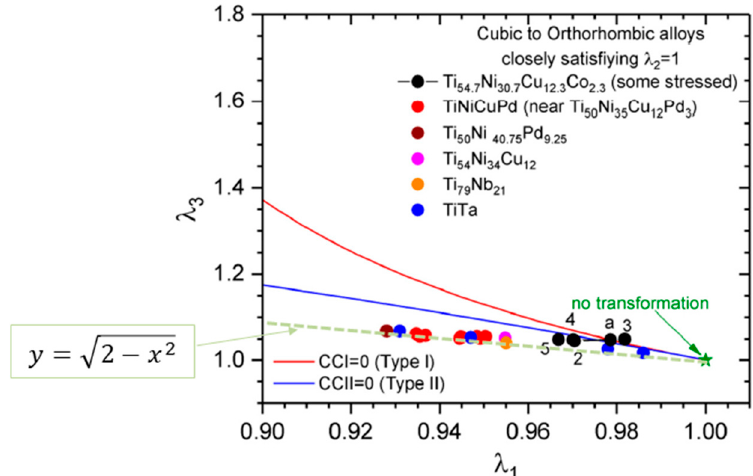
√ 2 − x 2 in a green dash color